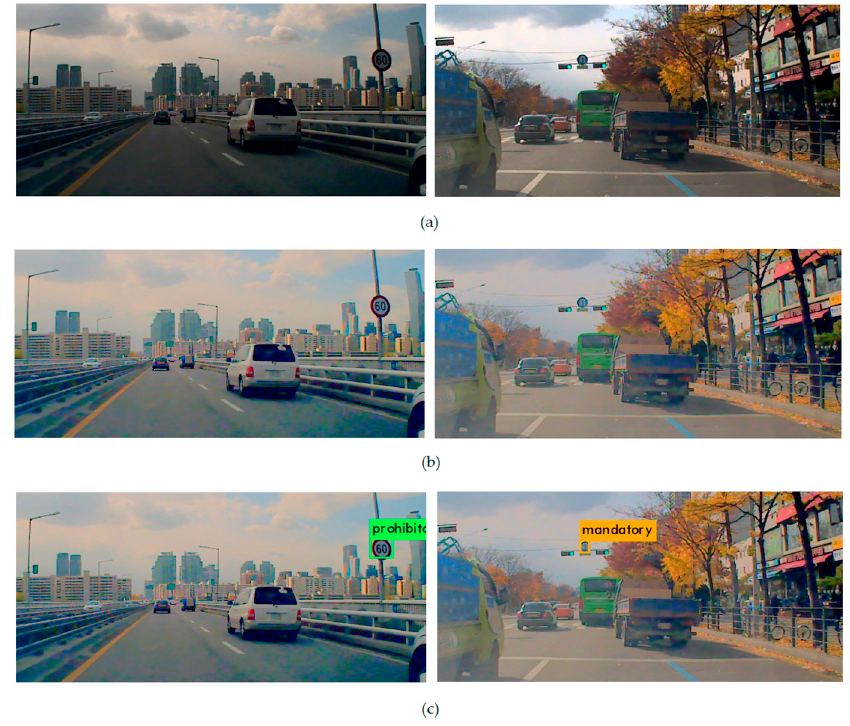
Figure 3. ( a ) Original dark images; ( b ) improved luminance by tone mapping; and ( c ) detection of traffic signs.